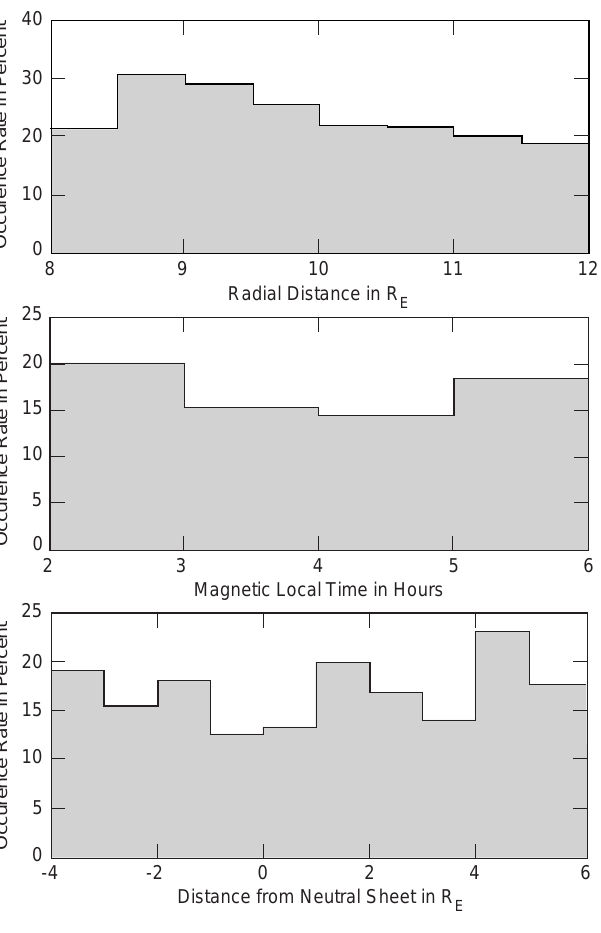
Fig. 3. Occurrence rate of electron whistlers for j B j < 20 nT with respect to radial distance ( upper panel ), magnetic local time ( middle panel ), and distance from a model neutral sheet ( lower